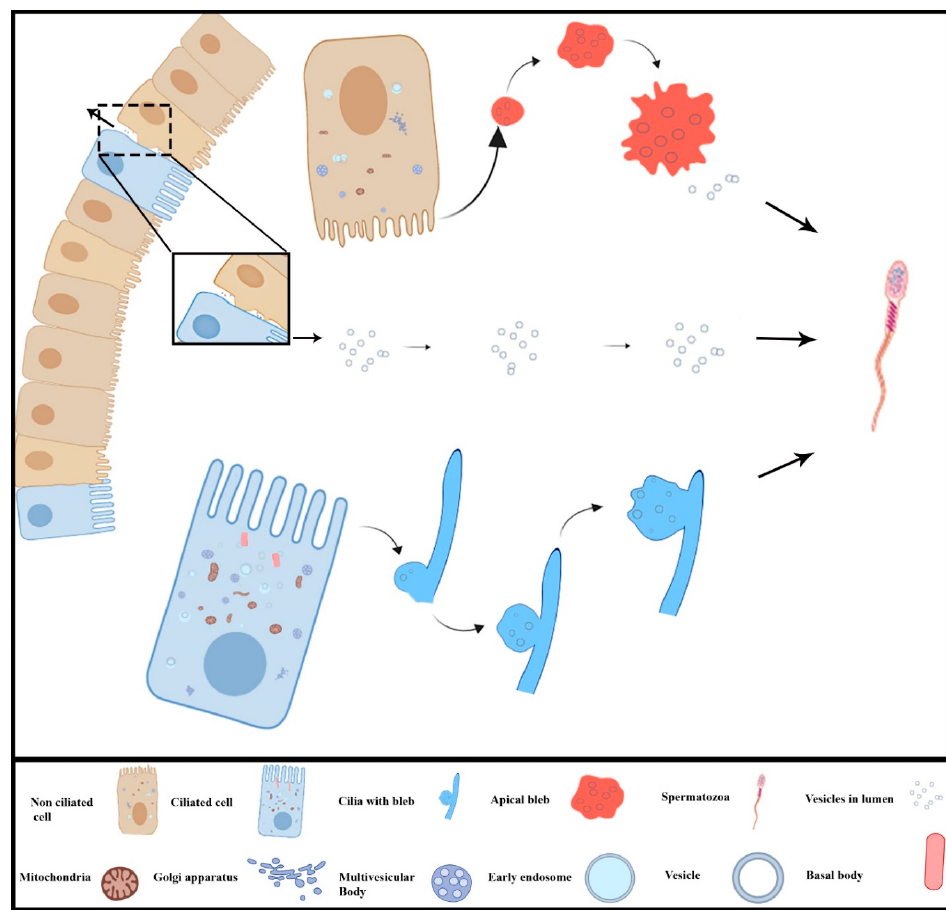
Figure 6. Schematic diagram of di ff erent routes of micro-vesicles secreted by the ciliated and non-ciliated Figure 6. ( A–D ) Schematic diagram of different routes of micro-vesicles secreted by the ciliated and cells of ductuli e ff erentes in the non-ciliated cells of ductuli efferentes in the turtle.